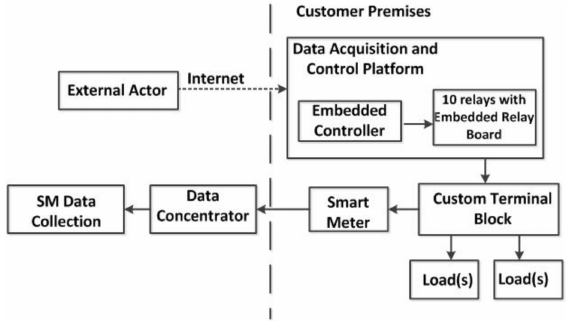
Figure 5. Block diagram of the devices used for the